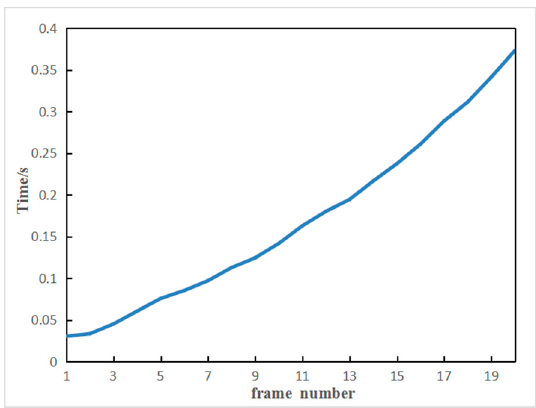
Figure 11. The curve of running time via the variance of frame number.